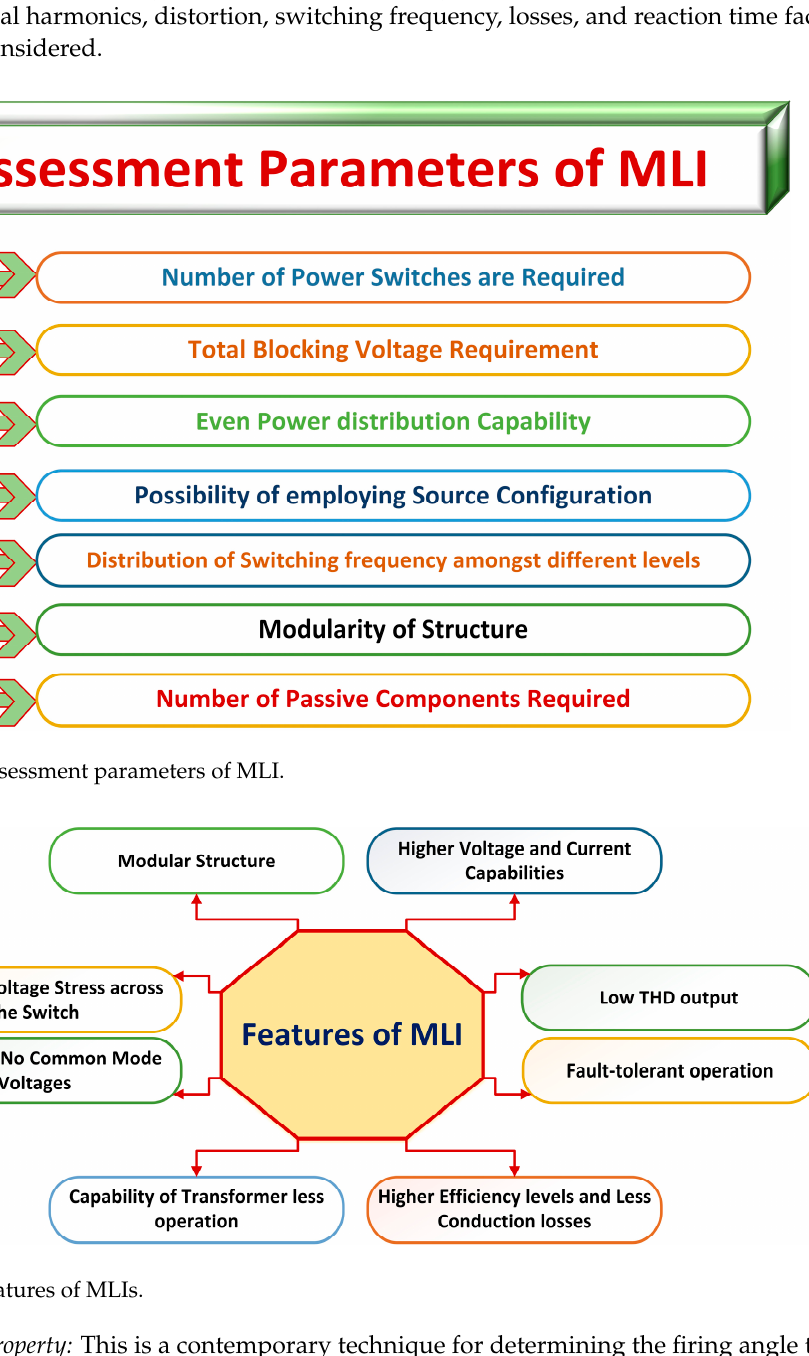
Figure 7. Classi fi cation of RSC-MLI topologies.